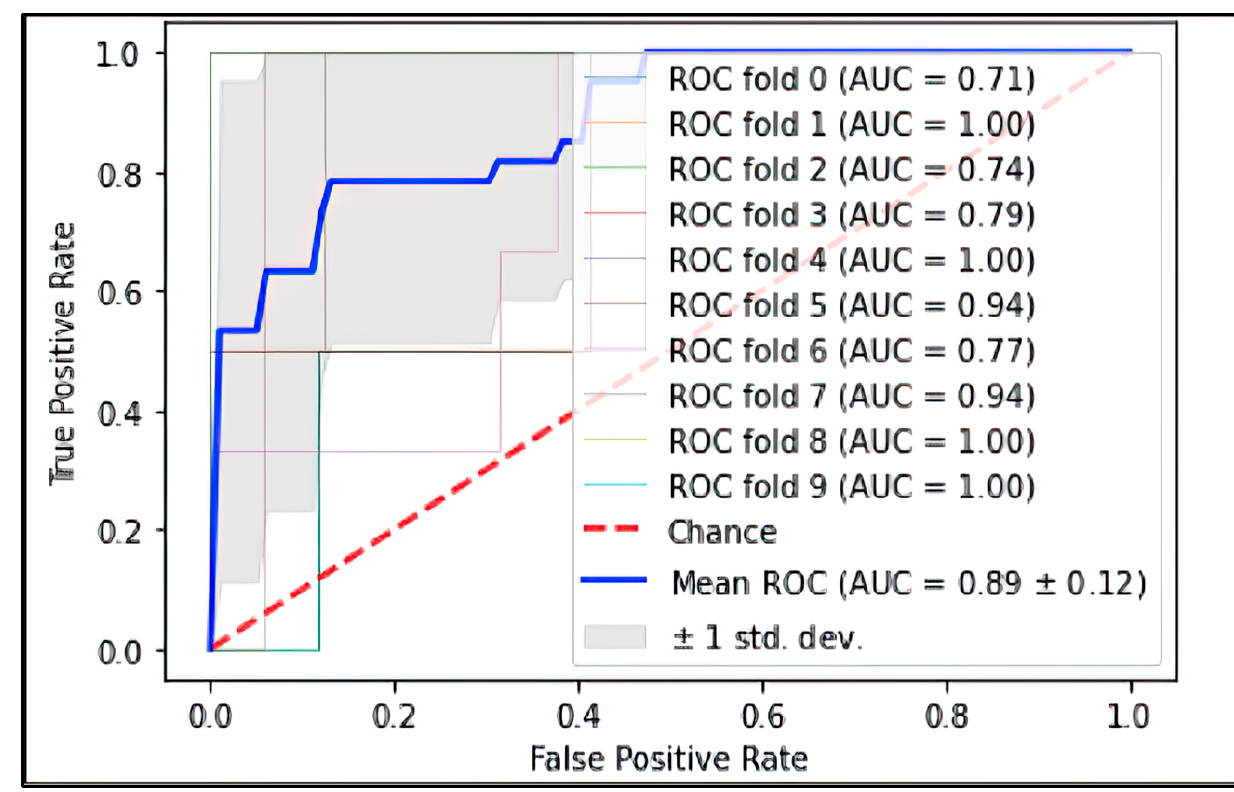
Figure 6. ROC illustration of the random forest model for prediction of sfGA using quantitative OCT-biomarkers including EZ At-Risk . Ten-fold cross validation was performed, and mean ROC results are represented by the blue solid line while random chance is represented by the red dashed line. ROC: receiver operator curve; sfGA: sub-foveal geographic atrophy; OCT: optical coherence tomography; EZ: ellipsoid